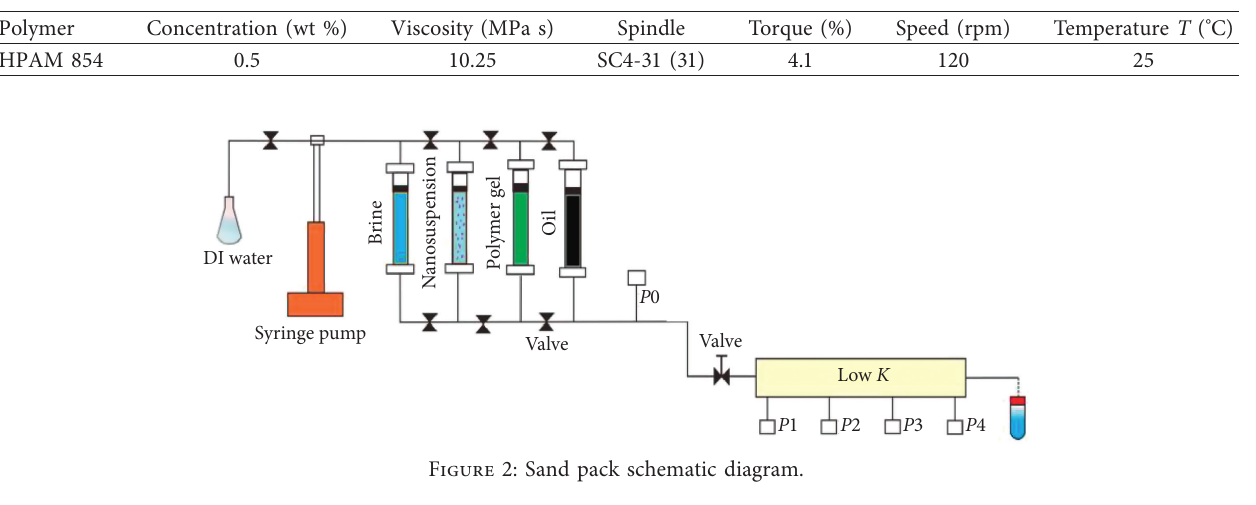
Table 2: Polymer gel (HPAM 854) viscosity measurements.